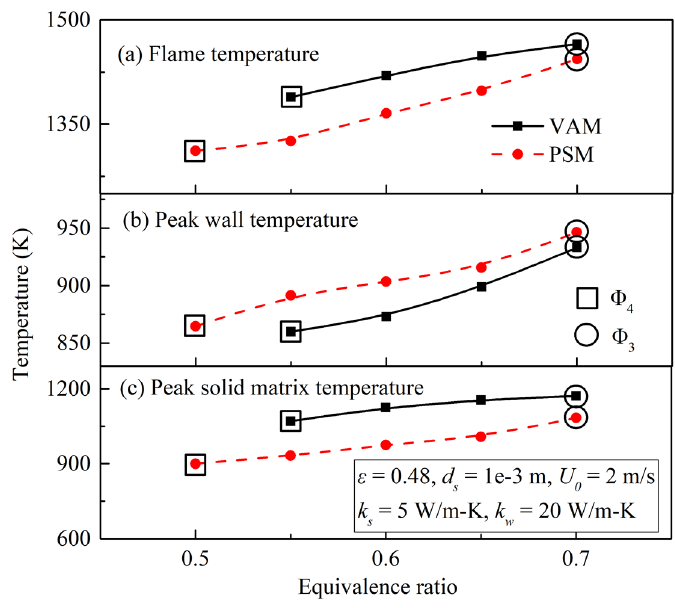
Figure 5. Comparison of temperature obtained by the PSM and VAM.